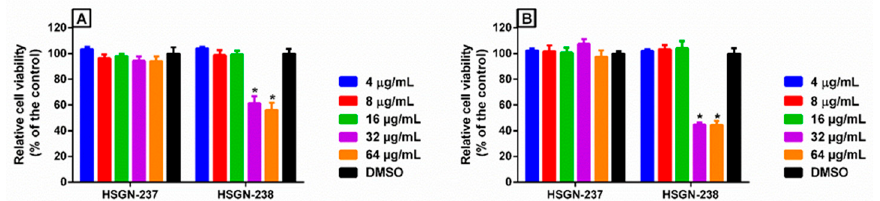
Figure 2. In vitro cytotoxicity assessment of HSGN-237 and -238 (tested in triplicate) against human colorectal cells (Caco-2) after ( A ) 24 h, and (B ) 48 h, using the 3-(4,5-dimethylthiazol-2-yl)-5-(3-carboxymethoxyphenyl)-2-(4-sulfophenyl)-2H-tetrazolium (MTS) assay. Results are presented as percent viable cells relative to DMSO (negative control). Error bars represent standard deviation values. A two-way ANOVA, with post hoc Dunnet’s multiple comparisons test, determined the statistical difference between the values obtained for the compound and DMSO. Asterisks denote statistically significant differences between treatments of cells with either HSGN-237 or -238 as compared to DMSO-treated cells. The experiment was repeated 3 independent times.